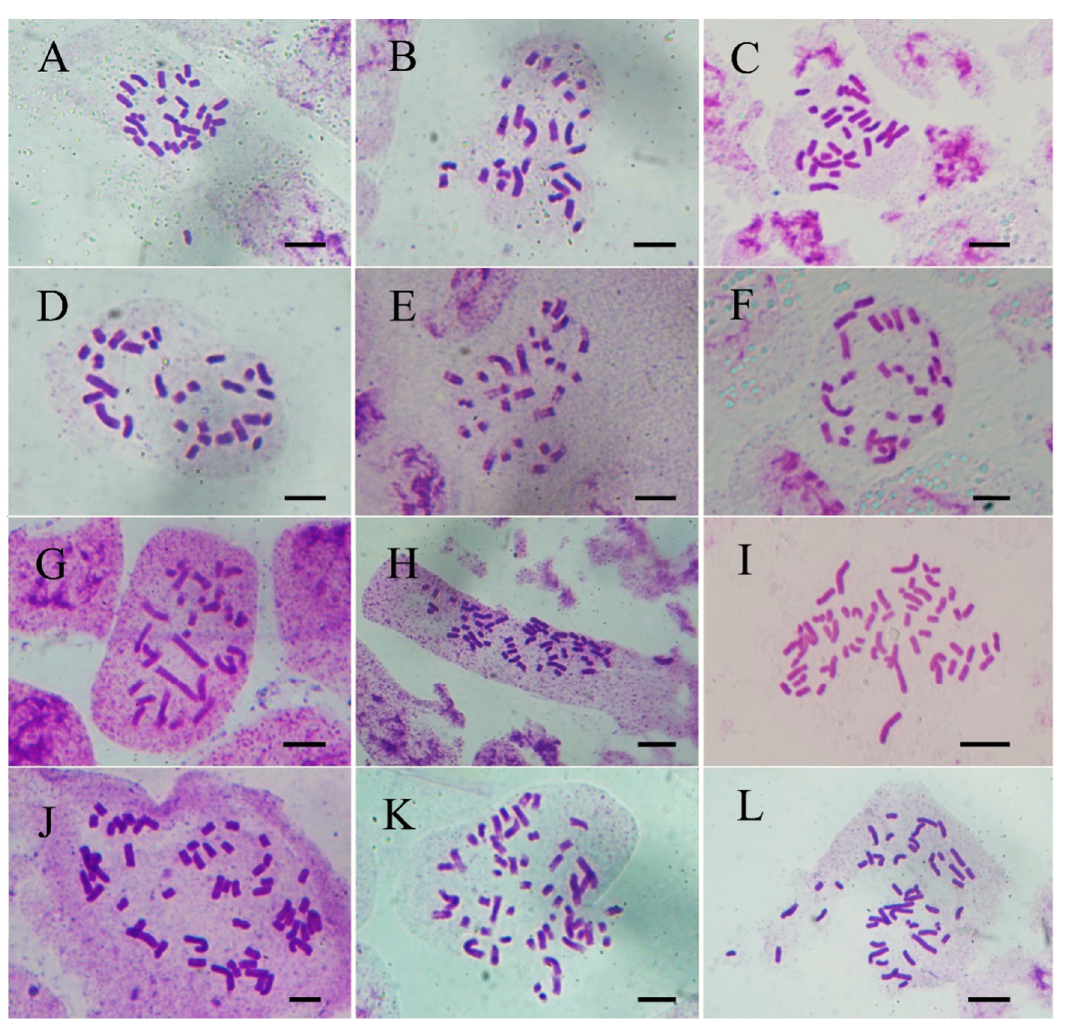
Figure 4. Micrographs of somatic chromosomes in the root tips of the randomly selected plants regenerated from the SVT9 and the SVT14 in vitro and their corresponding parent. ( A ) Wild SVT9 (2 n = 2 x − 2= 28); ( B ) SVT9-8 (2 n = 2 x − 3 = 27); ( C ) SVT9-14 (2 n = 2 x − 3 = 27); ( D ) SVT9-9 (2 n = 2 x − 1 = 29); ( E ) SVT9-11 (2 n = 2 x − 1 = 29); ( F ) SVT9-4 (2 n = 2 x = 30); ( G ) SVT9-23 (2 n = 2 x = 30); ( H ) wild